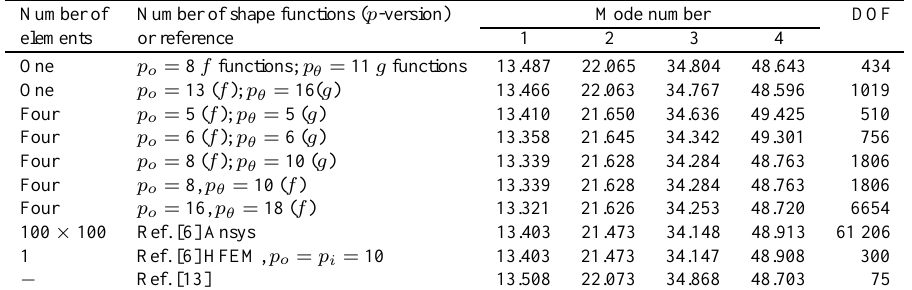
Table 2 First five frequency parameters of a FCFC cylindrical shell ( a/h = 100, a/b = 1, a/R = 0.5) Number of shape functions Mode number DOF or reference p o = p θ = 10 ( f functions)